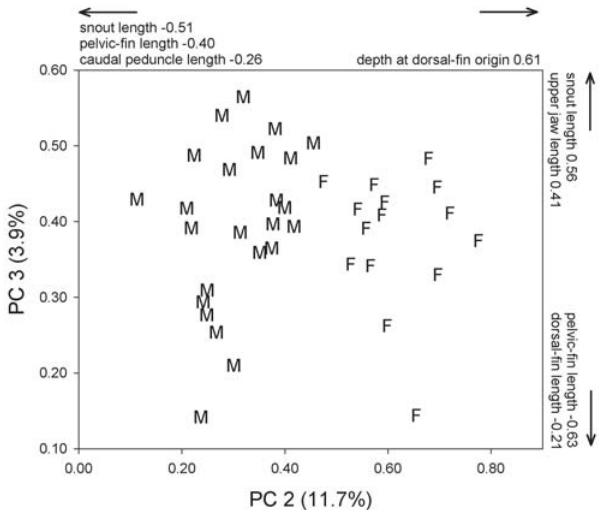
Fig. 17. Principal component analysis of the 18 morphometric data of males (M) and females (F) of Odontostilbe ecuador- ensis . Stronger loadings on the second and third principal components (PC2,